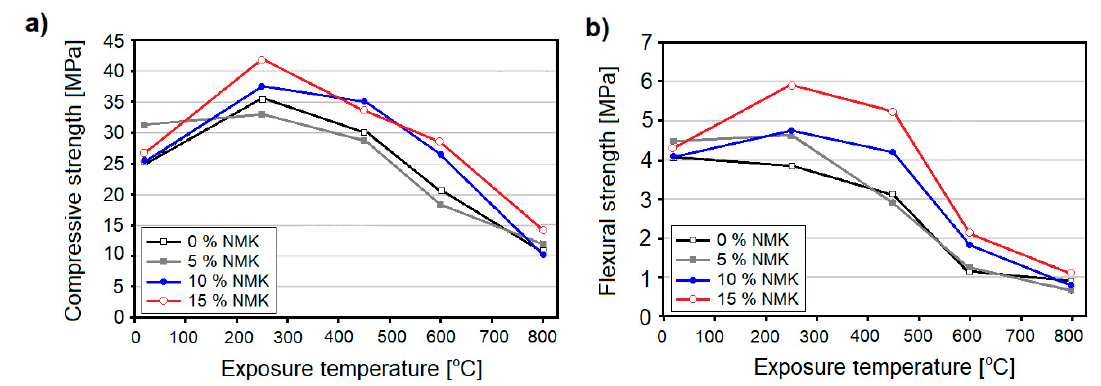
Figure 13. Compressive strength ( a ) and flexural strength ( b ) of cement mortars containing various amount of nano metakaolin (NMK), after thermal exposure. Reproduced with permission from [68]. Copyright Elsevier, 2012.